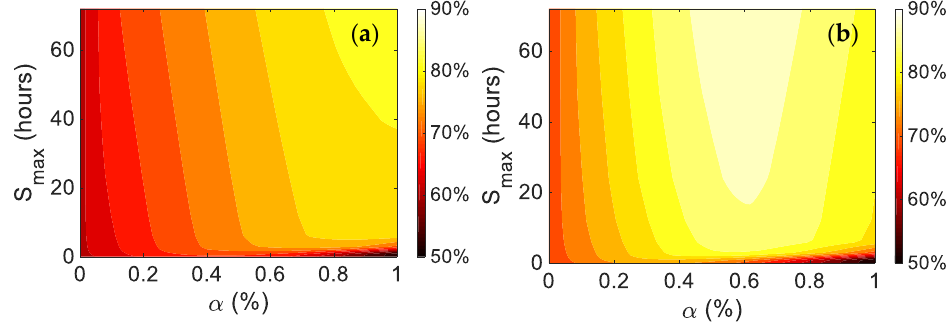
Figure 6. Influence of storage capacity available for solar PV ( y -axis) on the electricity demand satisfaction (color map) as a function of the share between solar PV and RoR power generation within the mix ( x -axis). Results are shown for Saldura at Mazia ( a ) and Posina at Stancari ( b ) and are obtained for a CHP heat penetration level 𝐻 𝑠 = 1 , which correspond to CHP electricity share 𝑆 𝐶𝐻𝑃 = 0.09 and 𝑆 𝐶𝐻𝑃 = 0.08 , respectively.